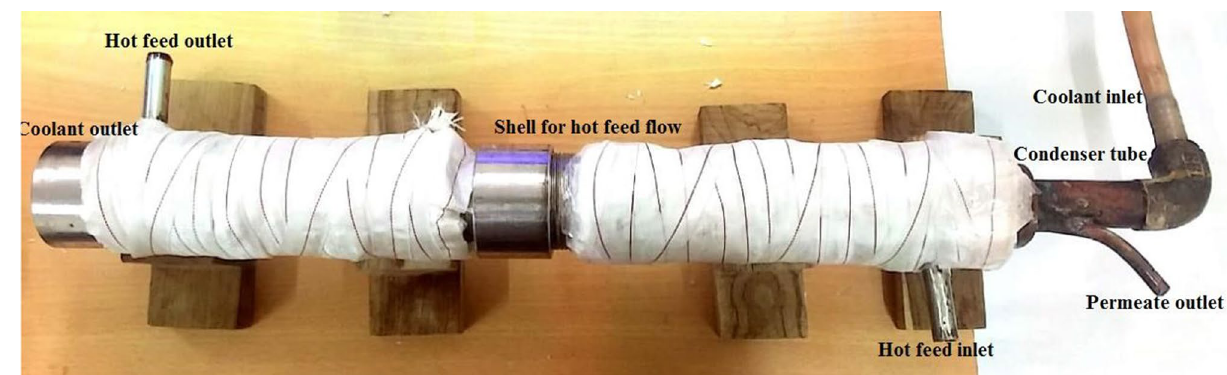
Fig. 4 Actual image of HAGMD module used in the present